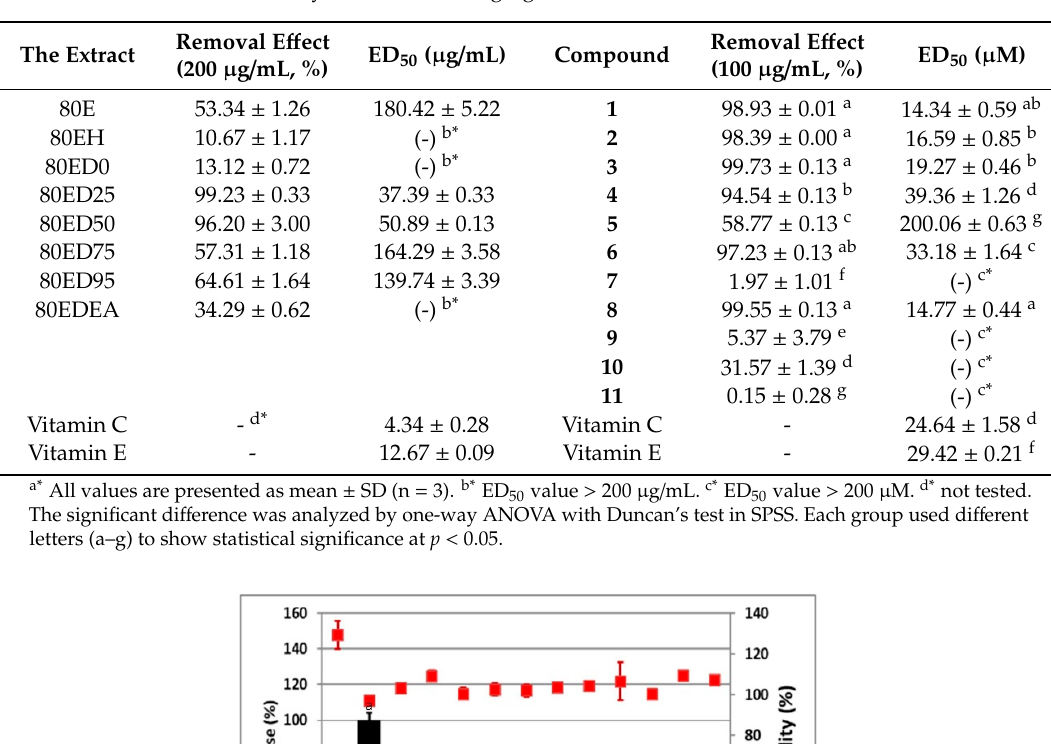
Table 5. Antioxidant activity of DPPH scavenging a* for the extract, fractions, and the isolates 1 – 11 .